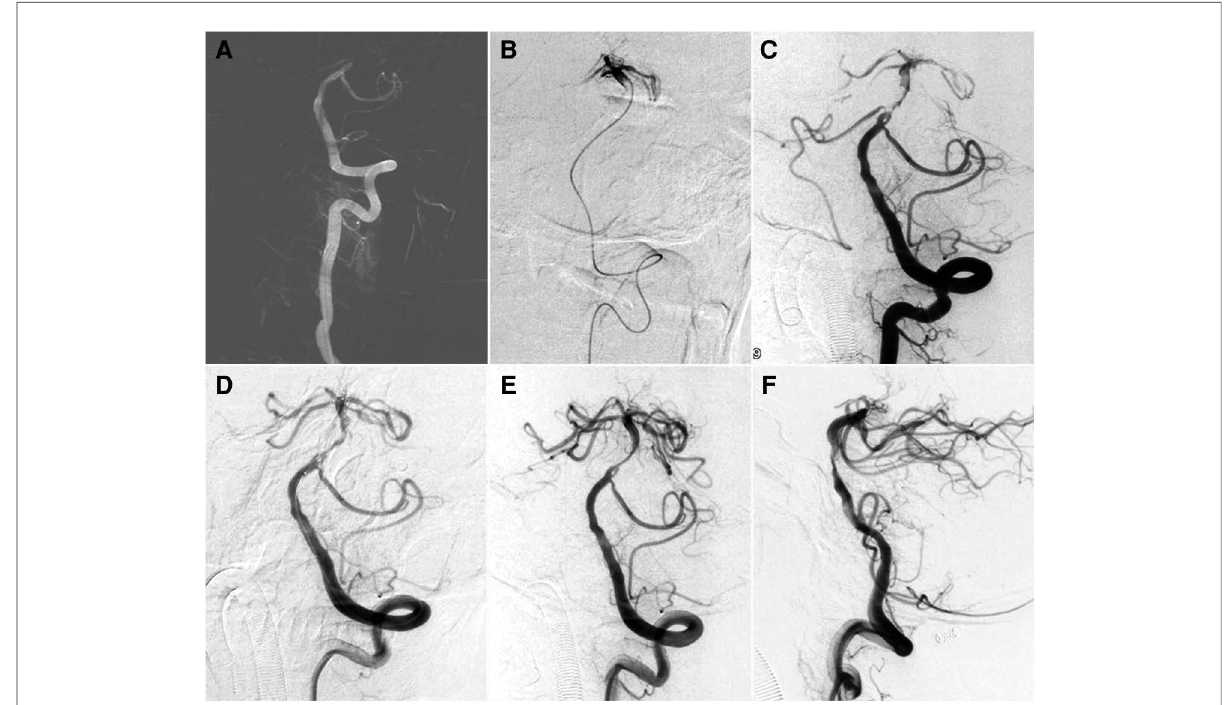
FIGURE 1 Mechanical thrombectomy for a patient with basilar artery trunk occlusion with underlying fenestration. ( A ) Left vertebral artery angiogram under roadmap showed basilar artery occlusion. ( B ) Angiogram via microcatheter after crossing the occlusion showed patent basilar terminus. ( C